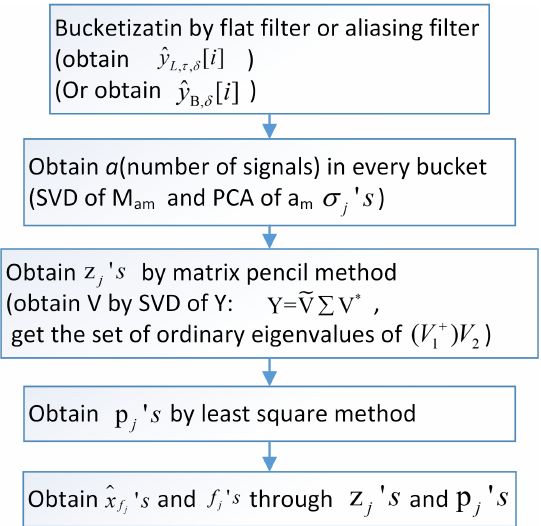
Figure 1. The block diagram of two new